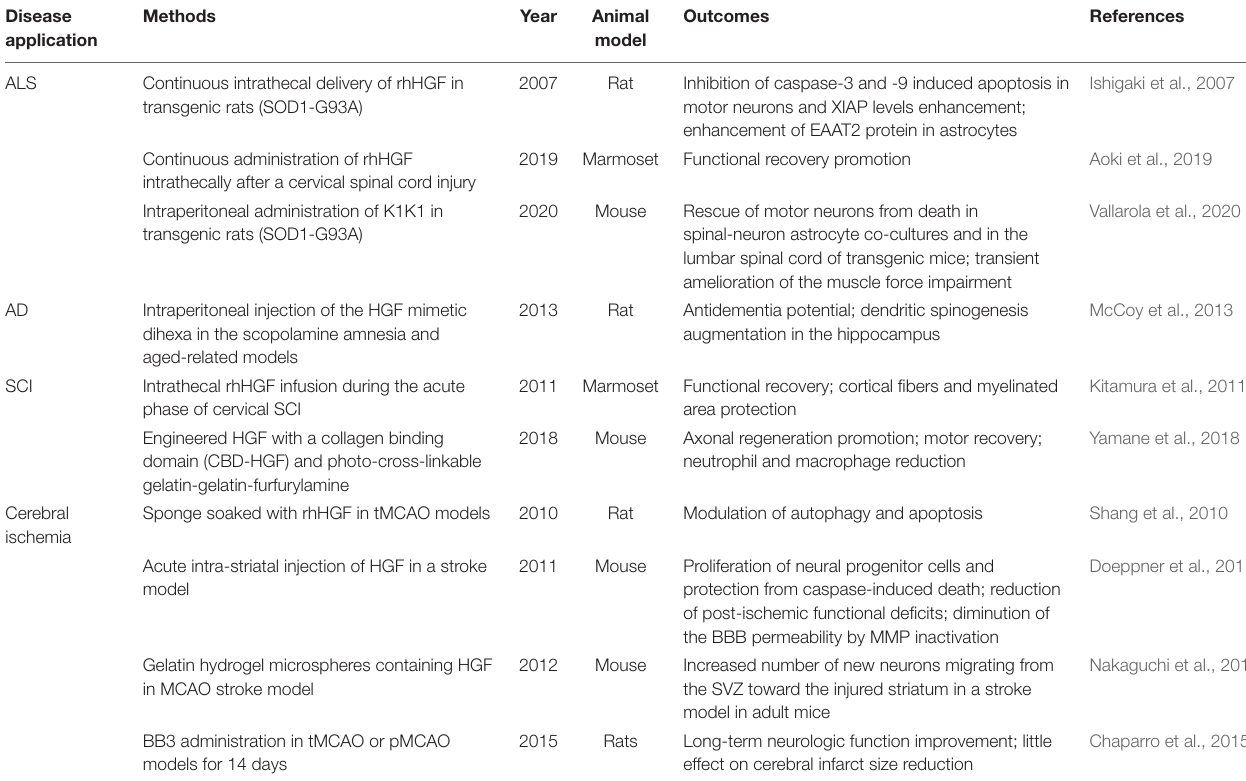
TABLE 1 | Administration of HGF and HGF mimetics in animal models of neurological diseases. Disease